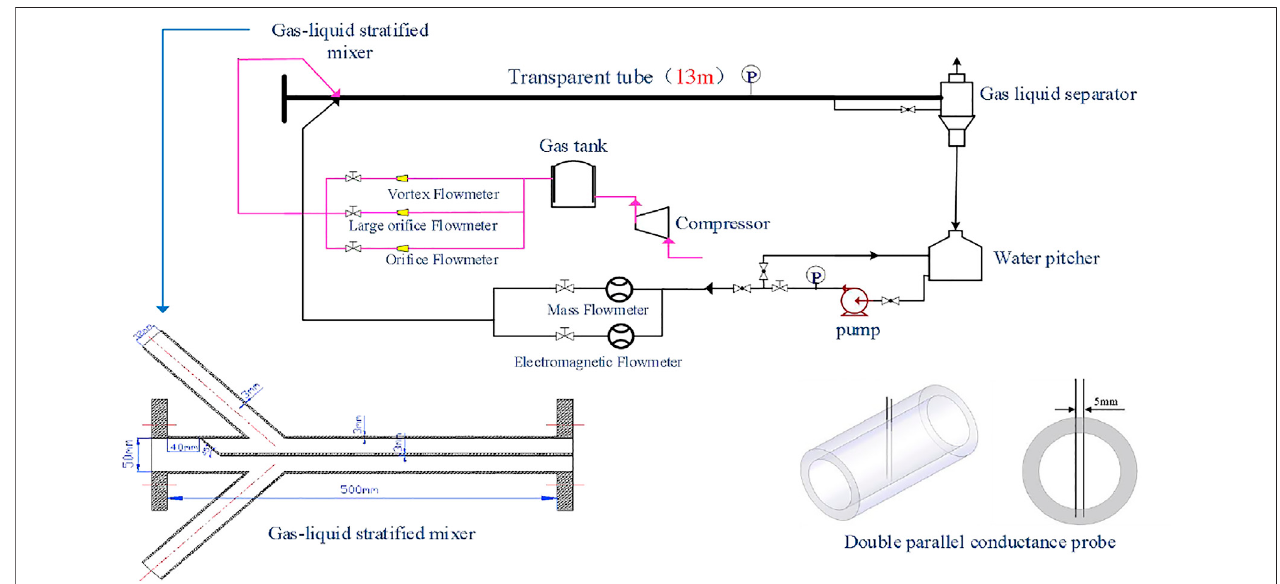
FIGURE 1 | Experimental